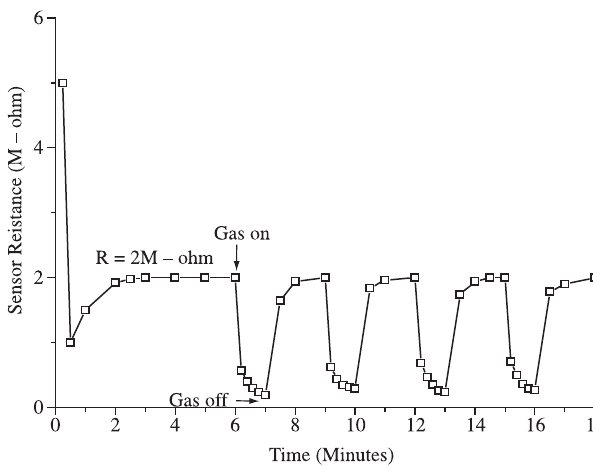
Figure 3. Warm-up time, sensing and recovery characteristics of the sensor